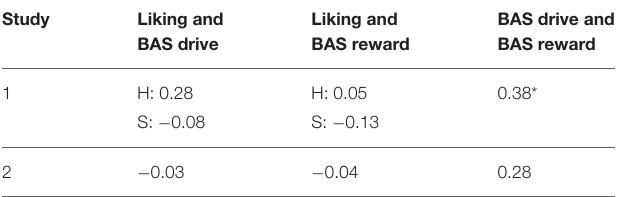
TABLE 2 | Pearson correlation coefficients (r) for the correlations between the difference in liking between the caloric and non-caloric stimulus, BAS drive and BAS reward